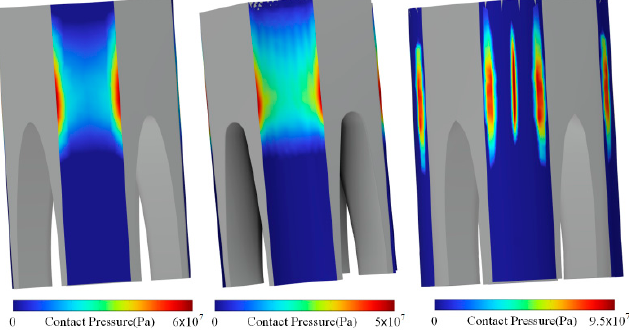
Figure 8. Contact pressure distribution.